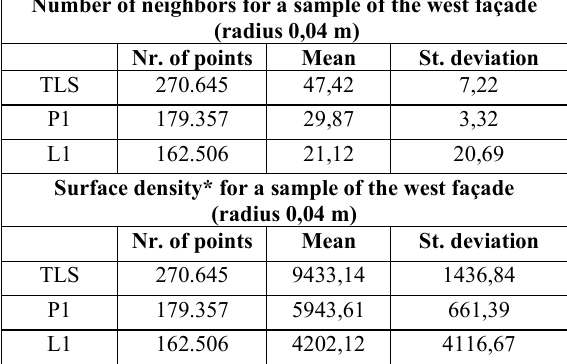
Table 7. Density analyses of the west façade section.